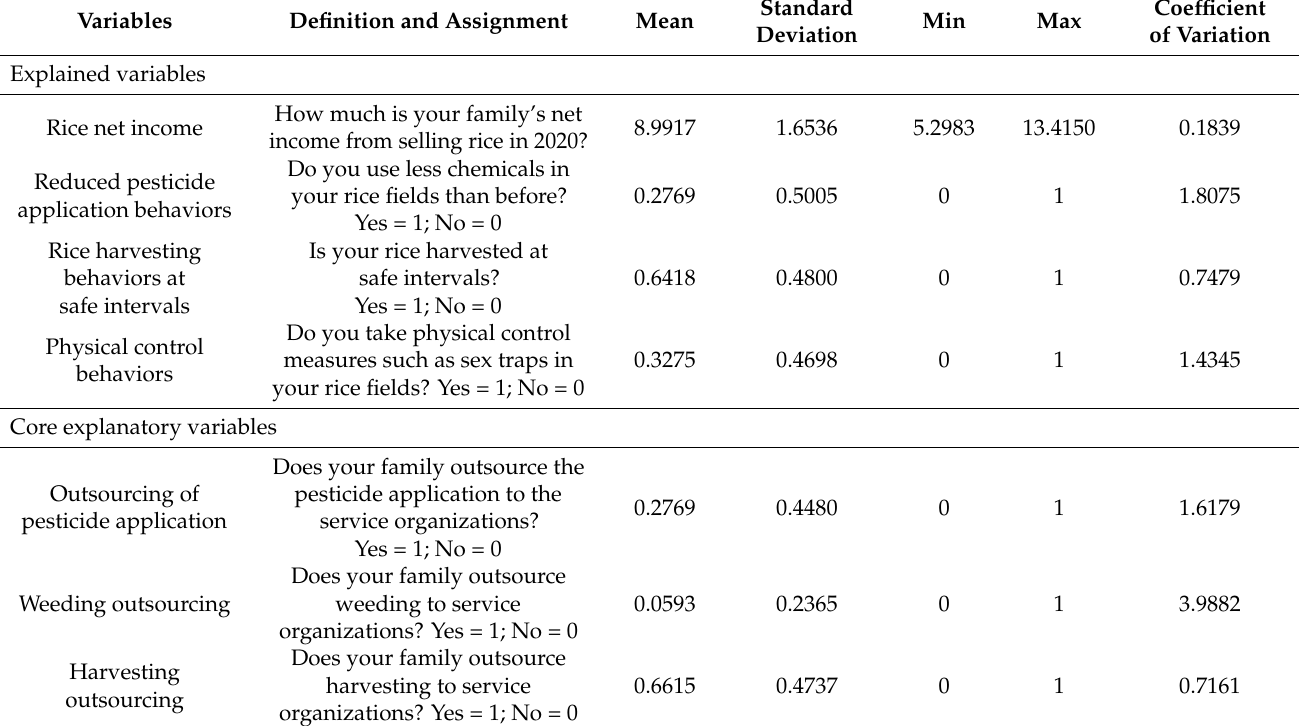
Table 1. Descriptive statistics of rice farmers’ characteristic